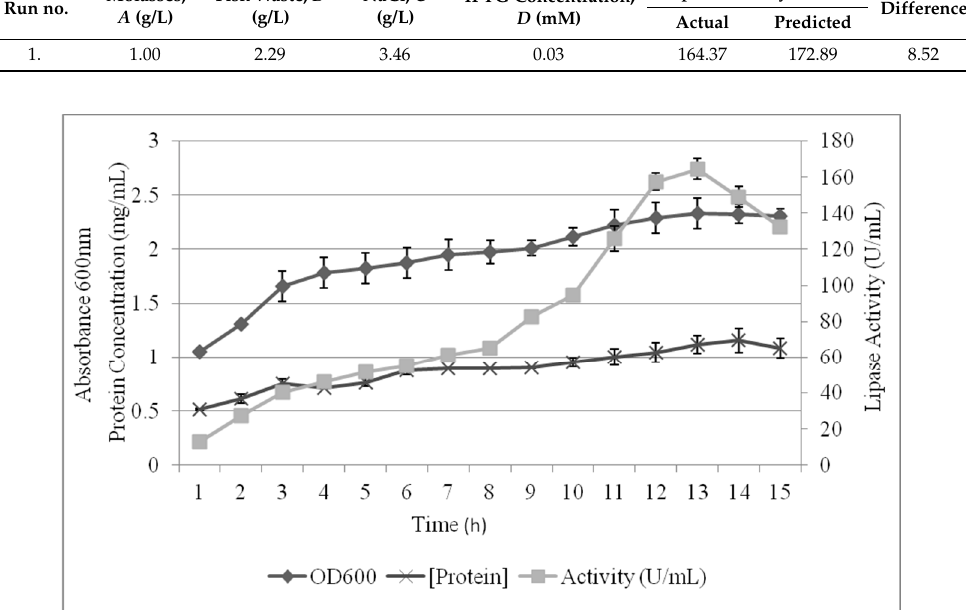
Figure 3. Effects of Different Parameters Involved in the Cultivation of T1 Lipase.